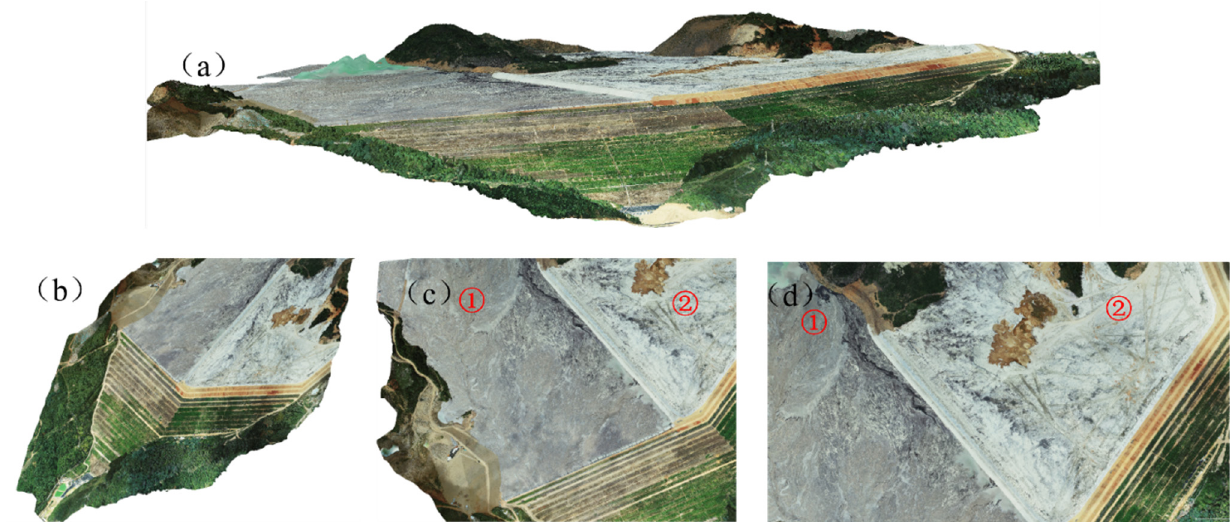
Figure 3. Construction of DIM point cloud. ( a , b ) the whole research area was completely constructed without point cloud holes. ( c , d ) disclosed that the tailings areas showed obvious contours. (1, 2 represent tailings areas have different water content).